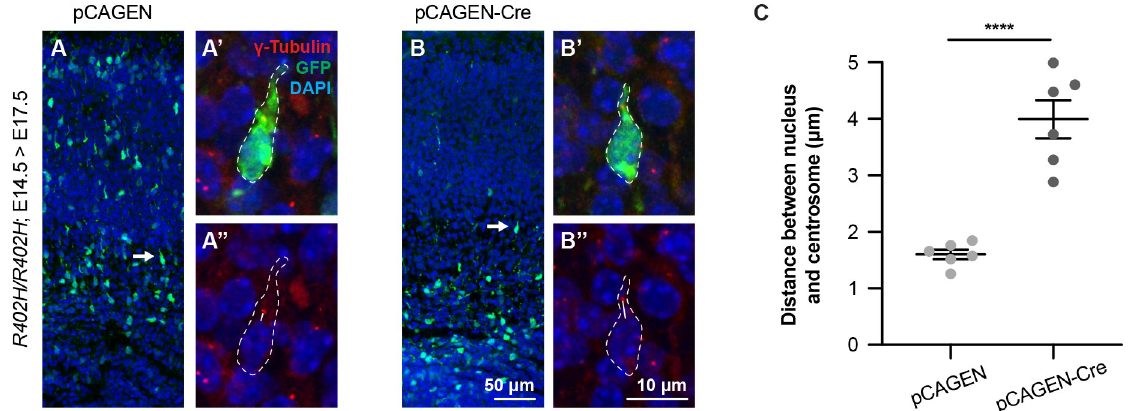
Fig 8. Acute expression of the R402H mutation perturbs nucleus-centrosome coupling in migrating neurons. (A-B) R402H/R402H animals were electroporated at E14.5 with either a pCAGEN control vector or pCAGEN-Cre vector to induce expression of the R402H mutation. Embryos were collected at E17.5 and sections stained with antibodies against GFP to label electroporated neurons and γ -Tubulin to identify the centrosomes. A’, A” and B’, B” show high magnification images of migrating neurons (arrow). (C) Quantification reveals a significant increase in the distance between the nucleus and centrosome in migrating neurons expressing the R402H allele in comparison to controls (n = 6 animals, minimum 6 cells per animal, P < 0.0001). Error bars in C show the mean ± s.e.m. ���� P < 0.0001. Scale bars show 50 μ m in B and 10 μ m in